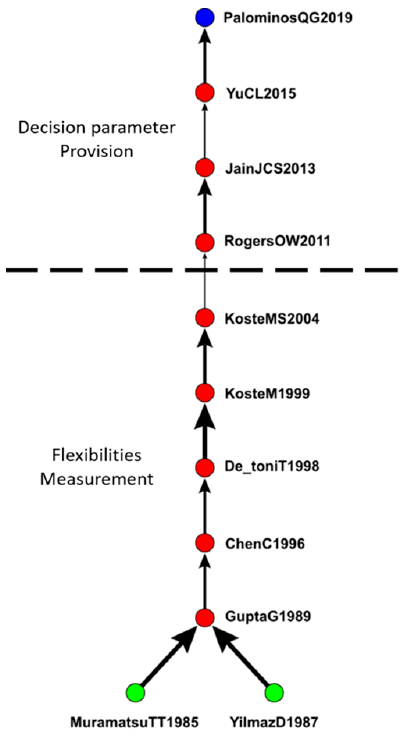
Figure 8. Global main path of FMS flexibility measurement.